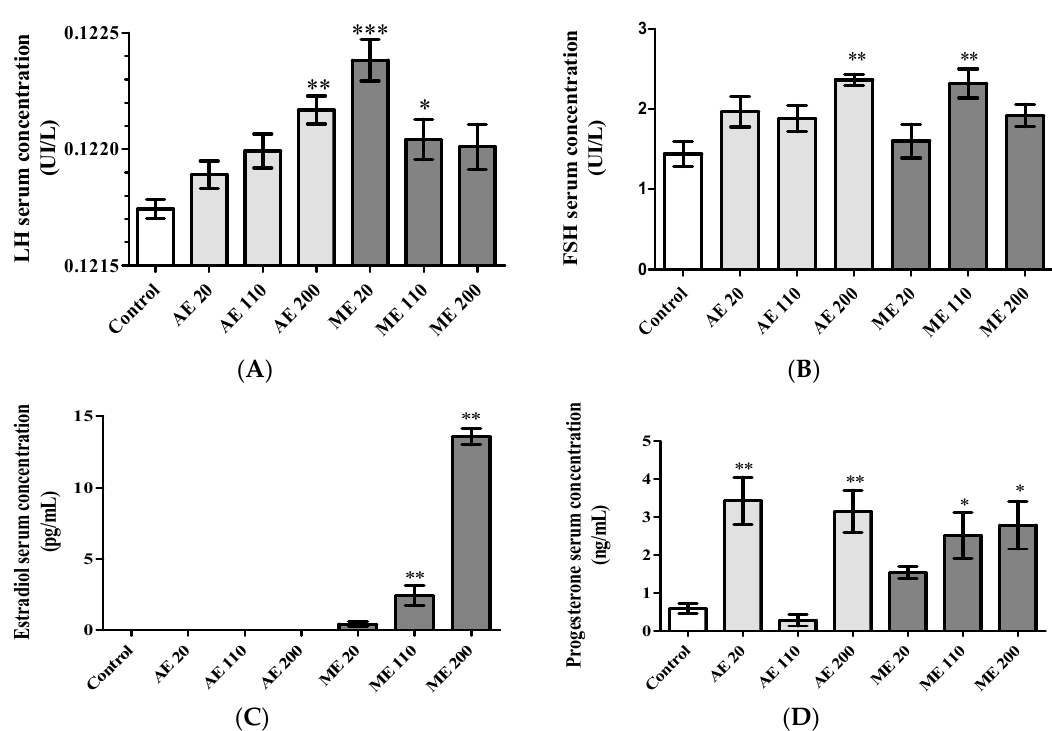
Figure 6. Serum levels of Luteinizing Hormone (LH) ( A ); Follicle Stimulating Hormone (FSH) ( B ) estradiol ( C ) and progesterone ( D ). Control = Animals receiving vehicle (distilled water, 10 mL/kg BW); AE = animals treated with the aqueous extract of M. arboreus ; ME = animals treated with the methanol extract of M. arboreus . Results are shown as the mean ± SEM; *: p < 0.05; **: p < 0.01; ***: p < 0.001 in reference to control.